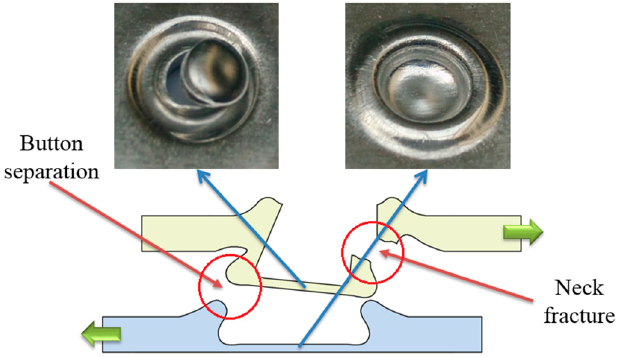
Figure 10. Mixed failure mode in the shearing test.